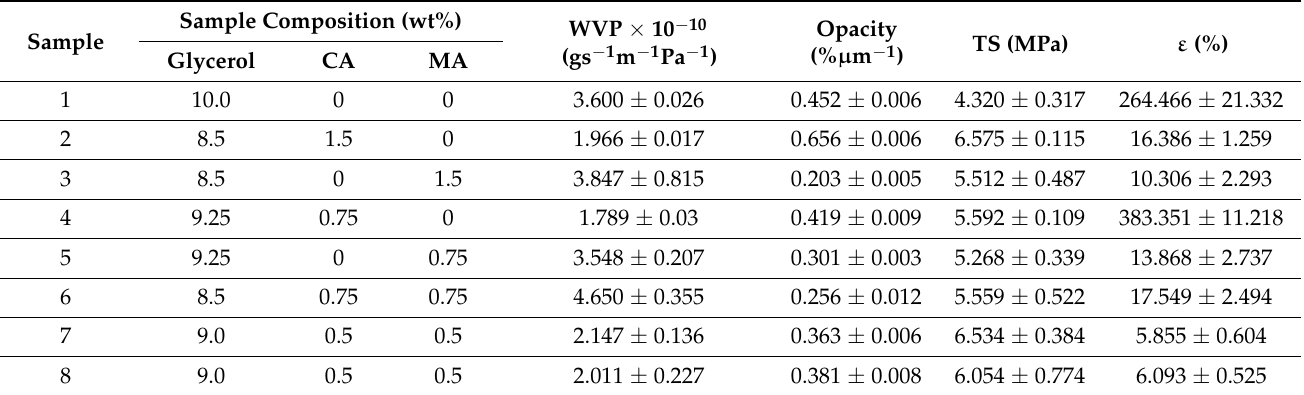
Figure 6. The formation of hydrophobic starch granule. Table 8. Summary of the study